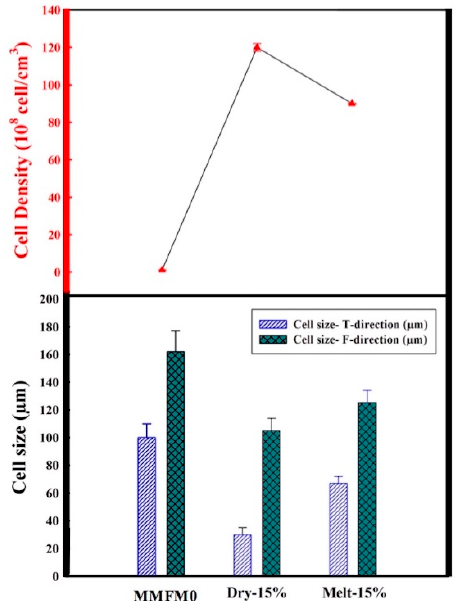
Figure 7. Effect of blending method (melt compounding and dry blending) on the cell size in both T and F directions, as well as cell density for MMFM0 and MMFM15.